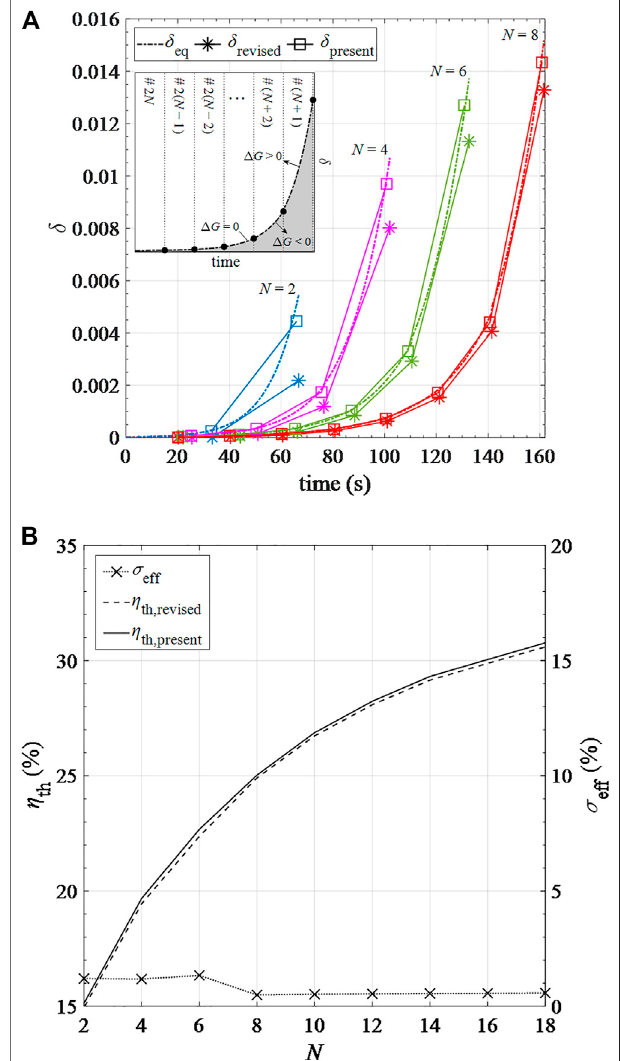
FIGURE 9 | Results of (A) δ over time based on the present model ( δ present ), the revised model ( δ revised ) and the equilibrium assumption ( δ eq ) in different pre-heating cavity numbers; (B) solar-to-fuel ef fi ciencies based on the present ( η present ) and revised ( η revised ) models and their relative errors σ eff in different pre-heating cavity